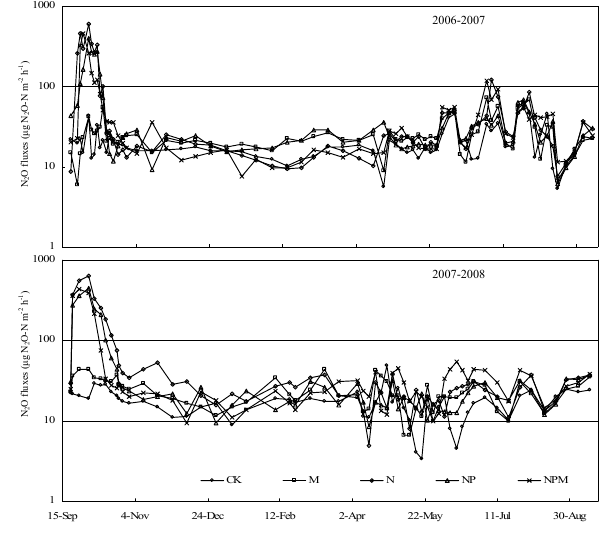
Fig. 2. N 2 O fluxes for different fertilization treatments from September 2006 until September 2008.